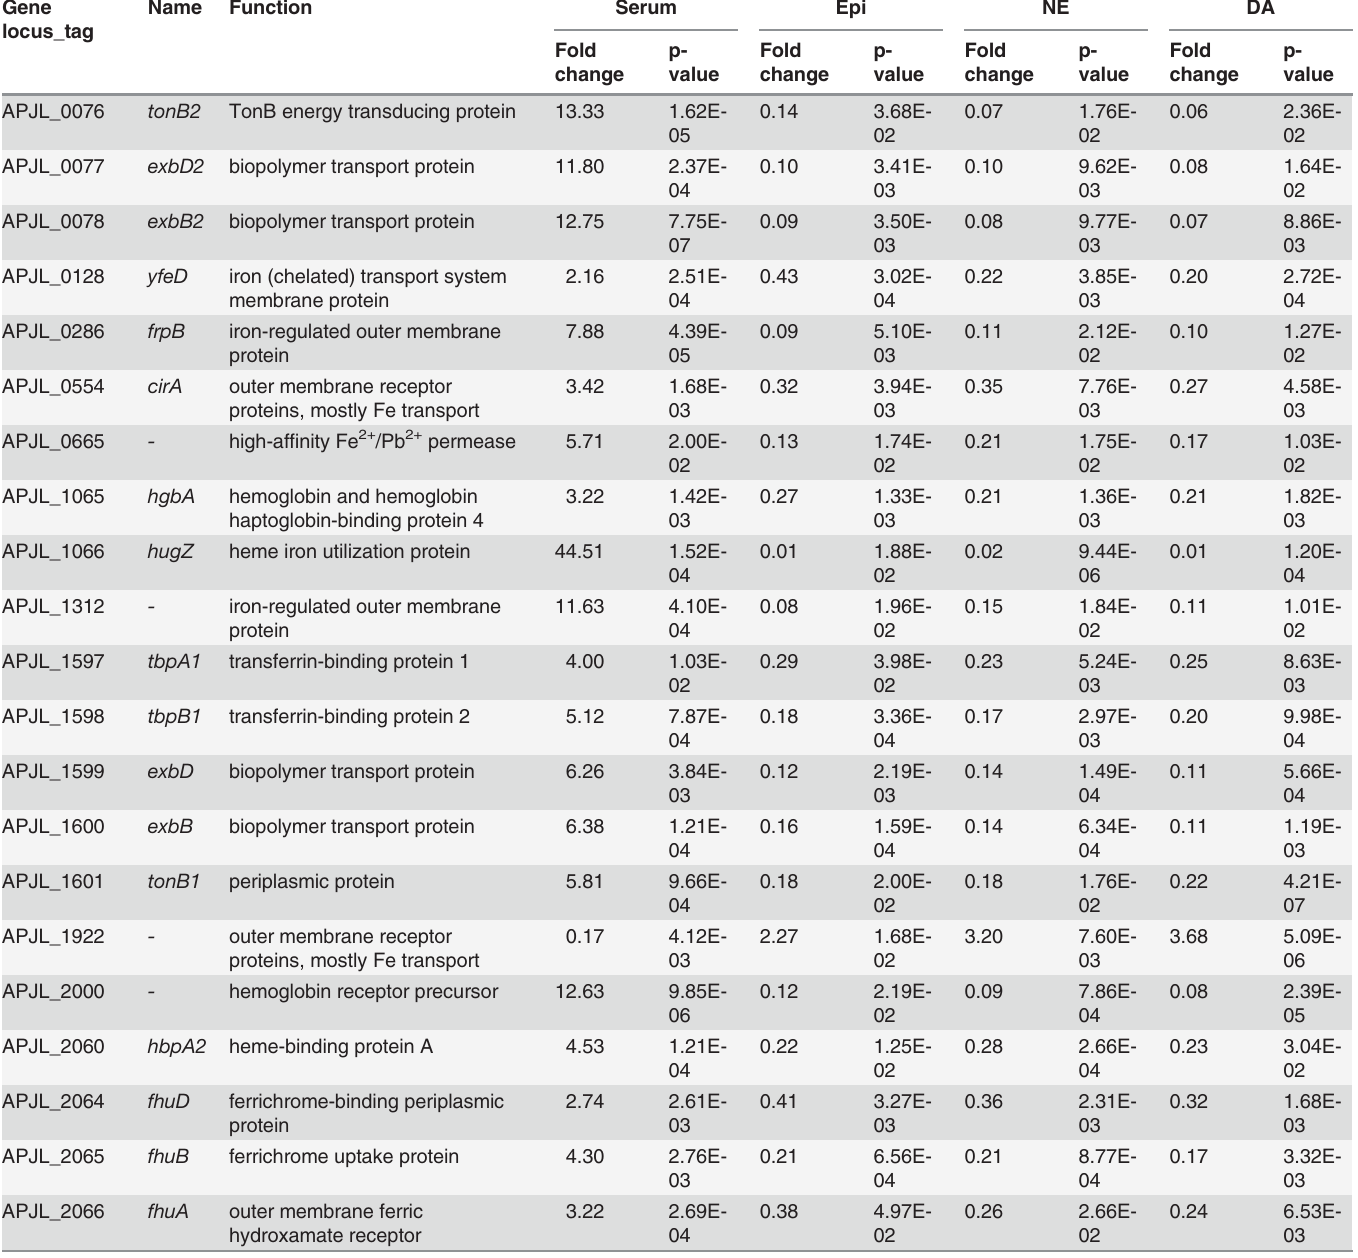
Table 1. Differentially expressed genes encoding iron metabolism proteins regulated by serum, Epi, NE and